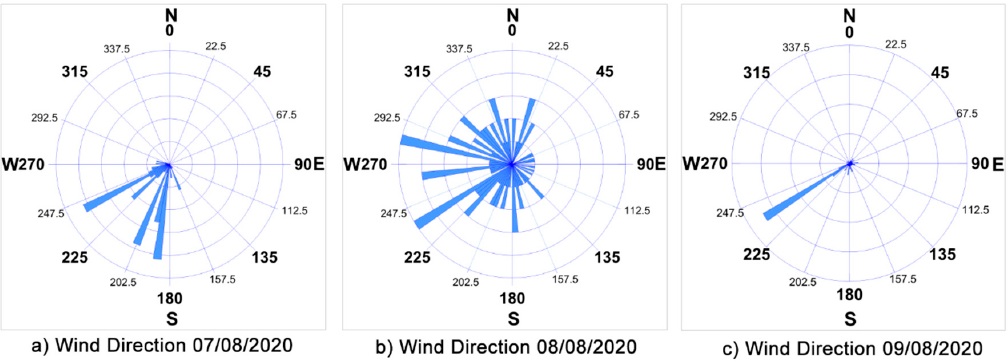
Figure 5. The wind direction distribution in 7–9 August 2019. ( a ) wind direction 07/08/2020; ( b ) wind direction 08/08/2020; ( c ) wind direction 09/08/2020.